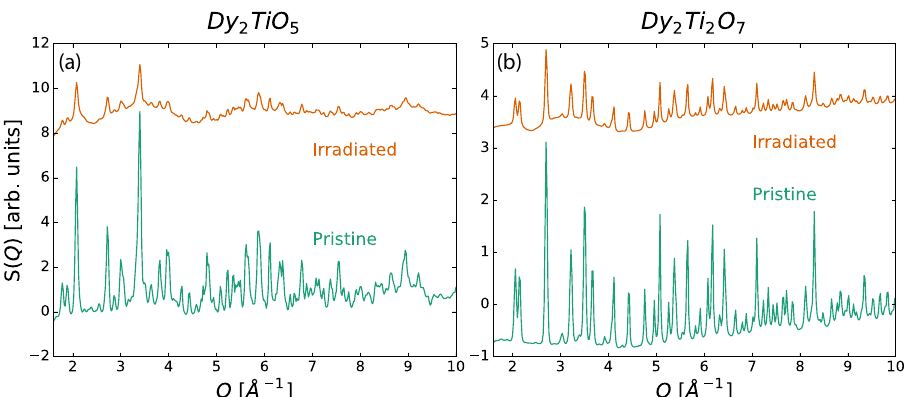
Fig. 2 Neutron total scattering structure functions of both dysprosium titanate oxides before and after ion irradiation. Diffraction pattern of ( a ) orthorhombic Dy 2 TiO 5 and ( b ) cubic Dy 2 Ti 2 O 7 with amorphization (loss of long-range periodicity) in both samples indicated by signi fi cant peak area reduction and increase in diffuse scattering. Irradiation was performed with 2.2 GeV Au ions with a fl uence of 8 × 10 12 ions/cm 2